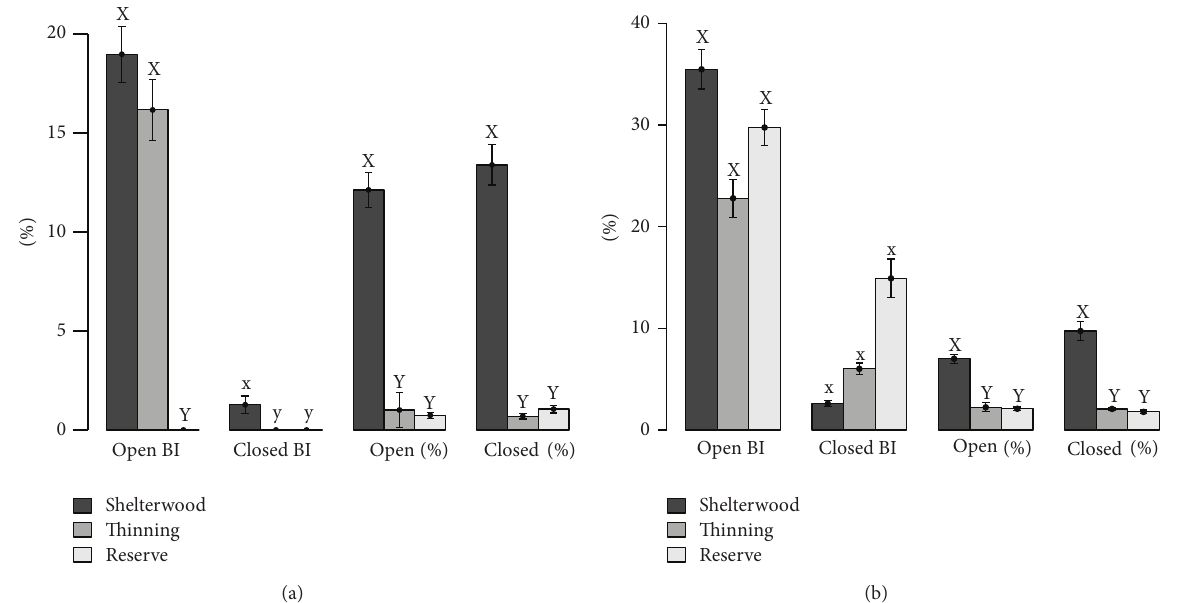
Figure 1: Browse index (left, BI) and percent cover (right, %) for the shrub plant group (a) and hardwood plant group (b) at YMF among open and closed plots by harvest strategy. Upper case versus lower case letters above standard error bars indicate values that are statistically different between open and closed plots by Tukey pairwise comparisons. Unlike letters of the same case indicate values that are statistically different between harvest strategies using Tukey pairwise